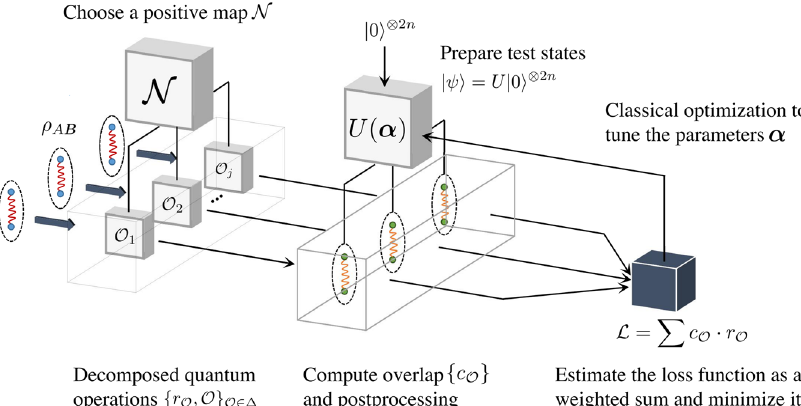
Fig. 2 The VED framework for detecting entanglement on near-term quantum devices. The difference between the deterministic VED in Algorithm 1 and the probabilistic VED in Algorithm 2 lies in how the decomposed quantum operations are